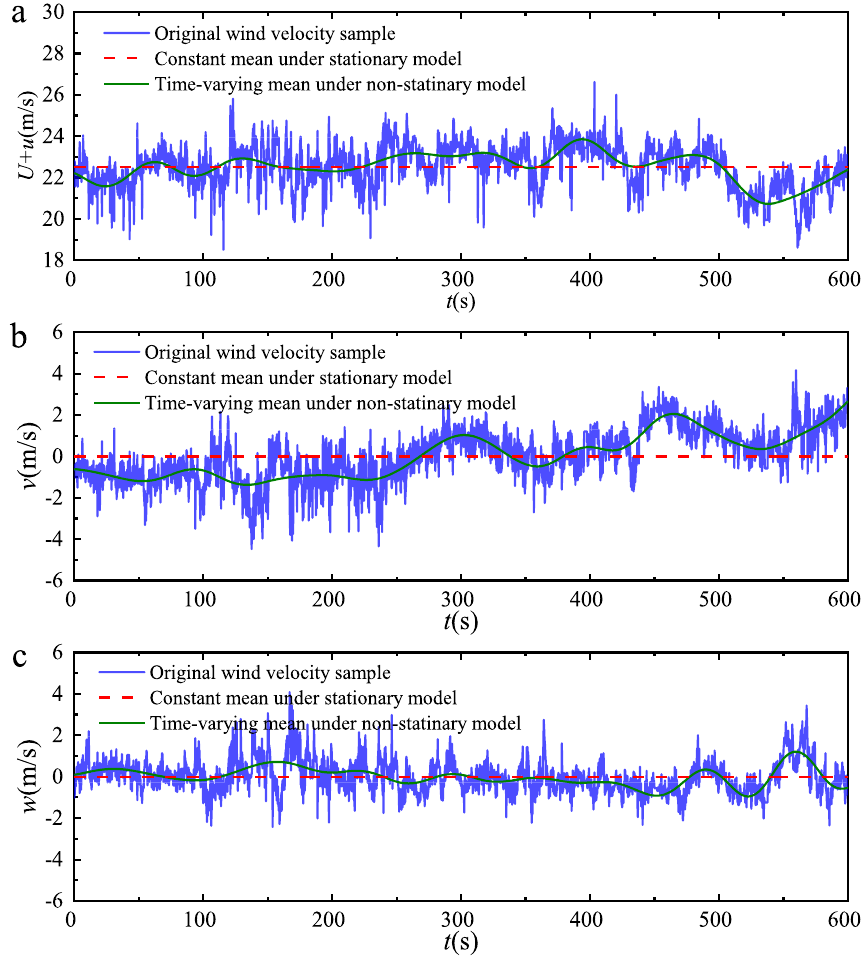
Fig. 4 Time histories of three fluctuating wind velocity components: a Longitudinal component; b Lateral component; c Vertical component